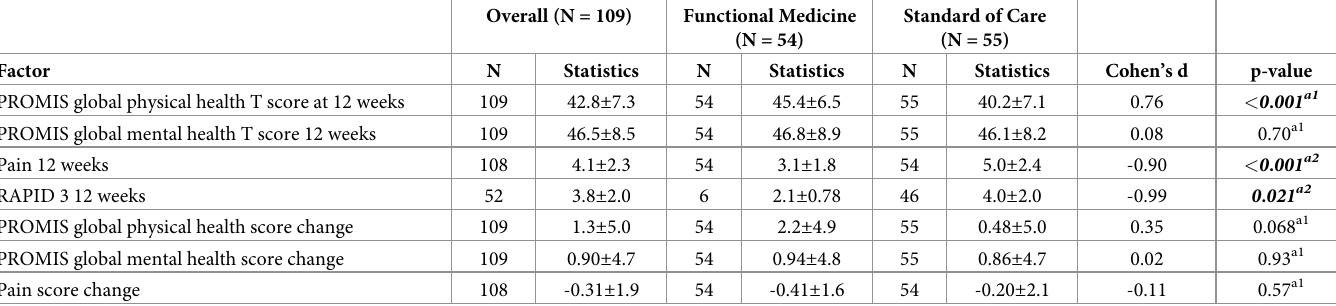
Table 2. Descriptive statistics on patient reported outcomes at 12 weeks, and change (12 weeks–baseline) in scores.